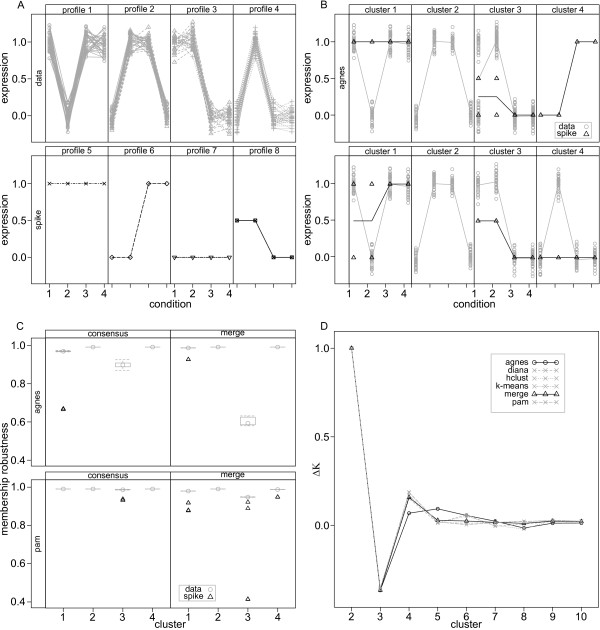
Consensus clustering with simulated gene expression profile data. (A) Simulated gene expression sets were generated randomly from normal distributions centred around four characteristic profiles (1,0,1,1), (0,1,1,0), (1,1,0,0), (0,1,0,0) which were then spiked with expression profiles centred on (1,1,1,1), (0,0,1,1), (1,1,0,0) and (0.5,0.5,0,0). (B) Unsupervised clustering with agnes and pam was used to partition the expression data into four clusters. Only profiles 1 and 2 were successfully identified by agnes, profiles 3 and 4 were consolidated and the (0,0,1,1) spike data segregated into a new profile (top row). Conversely, pam identified four expression profiles and segregated spike data into the closest matching profiles (bottom row). (C) Clustering with agnes and pam was repeated using clusterCons and the membership robustness calculated for each profile ('consensus' panels). For agnes, the spike data in cluster 1 are revealed as outliers (open triangles) and the robustness for cluster 3 is noticeably lower than clusters 1-4 reflecting its heterogeneity. Clusters produced by pam showed high robustness with only the spike data in cluster 3, observable as outliers (open triangles). Merge consensus matrices were generated from these two consensus clustering results and cast onto the agnes and pam clustering structures ('merge' panels) producing a more balanced view of membership (and hence cluster) robustness. For agnes, as expected, profiles 1, 2 and 4 remain largely unaffected, but profile 3 is heavily penalised as it is inconsistent between clustering algorithms. All pam profiles retain their high membership robustness, but now spike data are revealed for all profiles as outliers. (D) The optimal cluster number was estimated by finding the largest change in area under the cumulative density curve (AUC) for the consensus matrix of each clustering experiment by cluster number. Using this approach, the merge consensus matrix correctly predicted an optimal cluster number of 4, whereas agnes predicted 5.